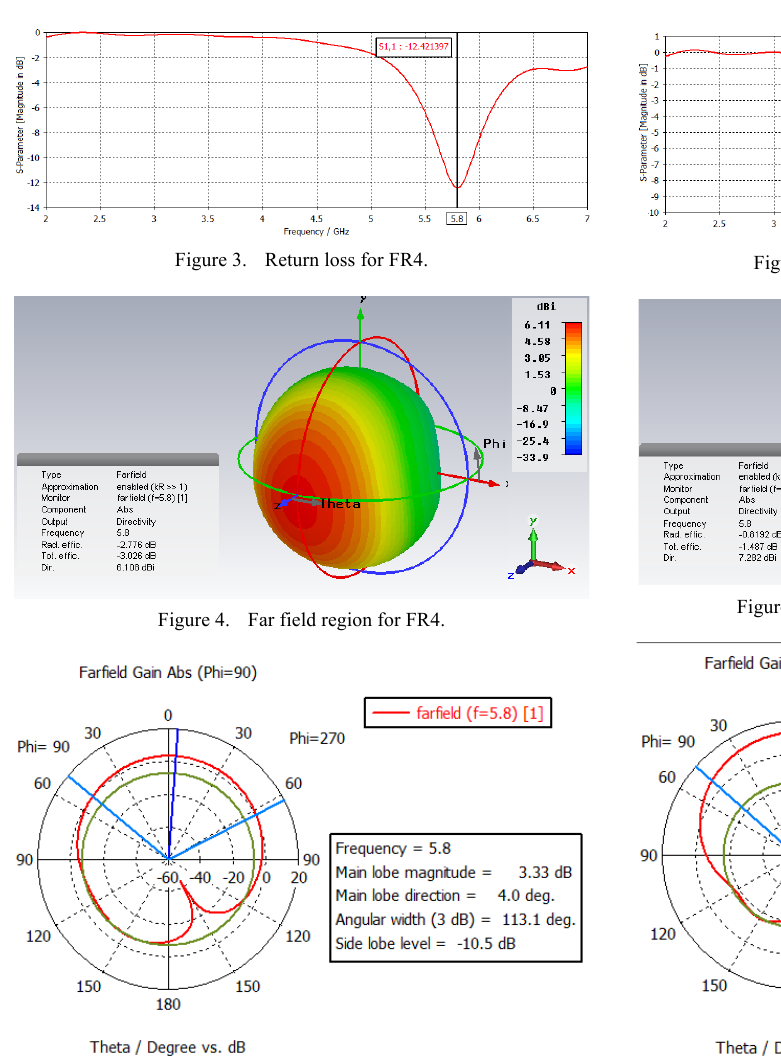
Figure 5. Far field in polar view for FR4.